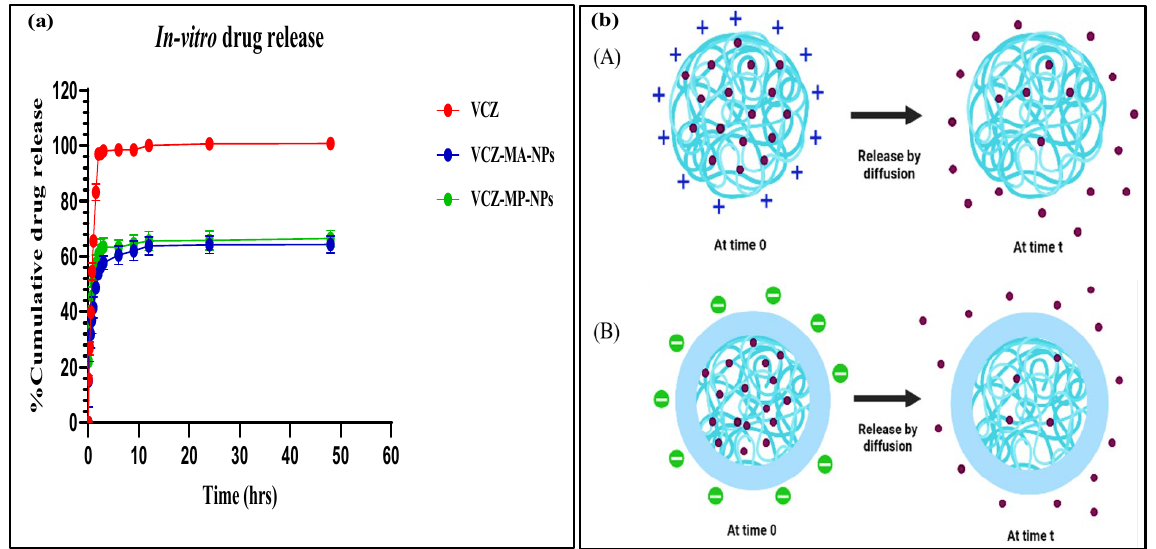
Figure 9. ( a ) In vitro percentage cumulative drug release from the VCZ solution, VCZ-MA-NPs, and VCZ-MP-NPs. Data are represented as mean ± SD ( n = 3), ( b ) pictorial release mechanism from (A) VCZ-MA-NPs with positive surface charge, and (B) VCZ-MP-NPs having negative surface charge.